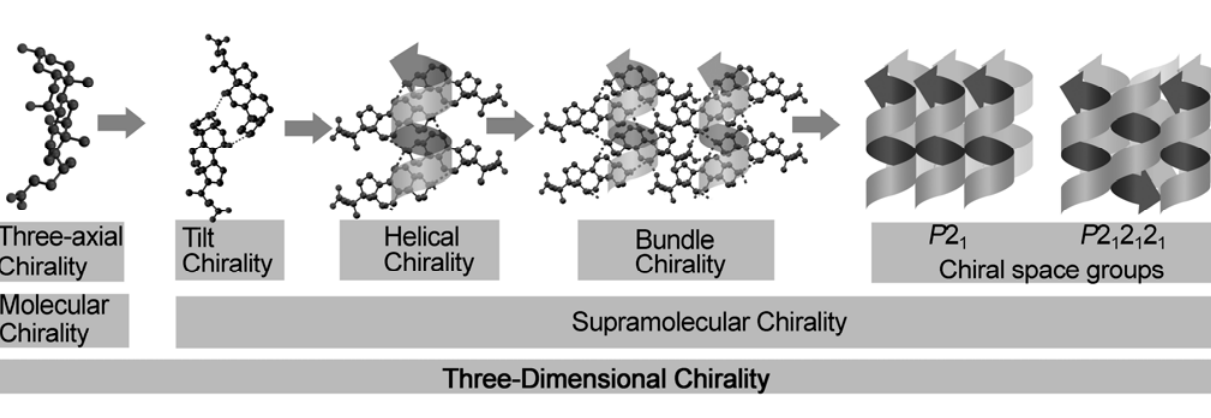
Figure 8. Molecular and supramolecular chirality of various molecular assemblies. Tilt chirality in a bimolecular assembly causes helical chirality in the resulting helical assembly. The helices are tied up to make various bundles as chiral crystals. The three- dimensional chirality of the molecular assemblies are interpreted in a hierarchical